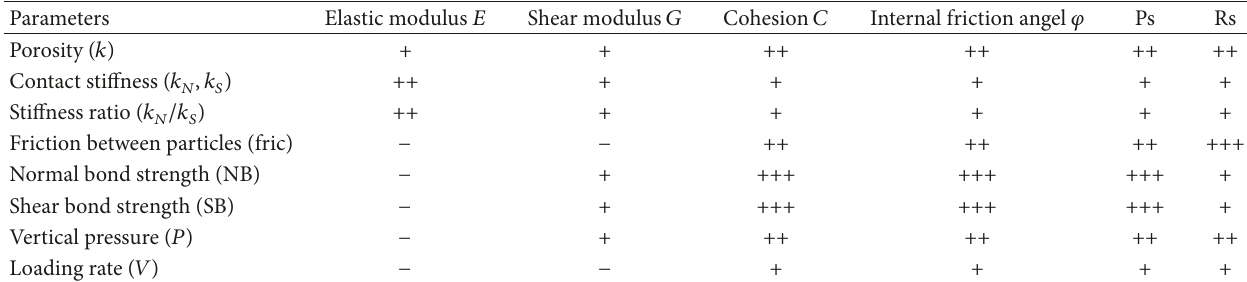
Table 2: Macroscopic response mechanism upon change of microscopic parameters.